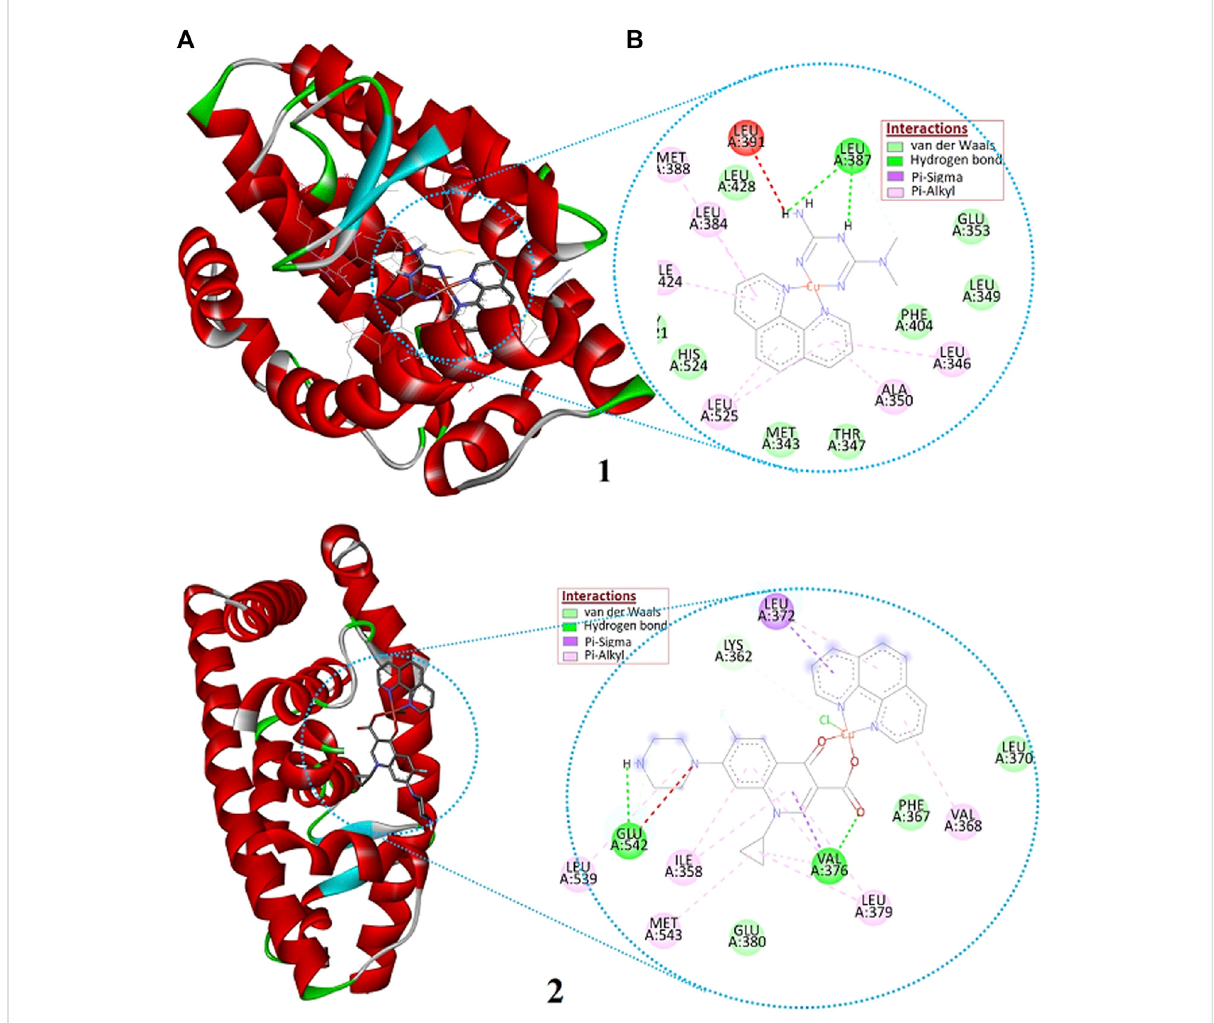
FIGURE 9 The (A) 3D and (B) 2D presentations of the binding interactions of complexes 1 and 2 against estrogen receptor alpha (ER α ; PDB: 5GS4).